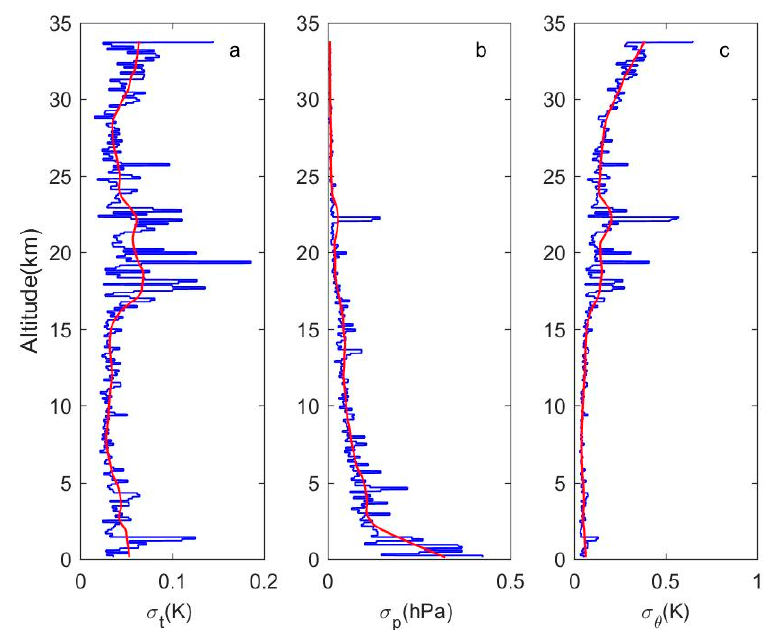
Figure 2. Noise standard deviation of ( a ) temperature, ( b ) pressure and ( c ) potential temperature (red curve: smoothed profiles of these noise estimates).